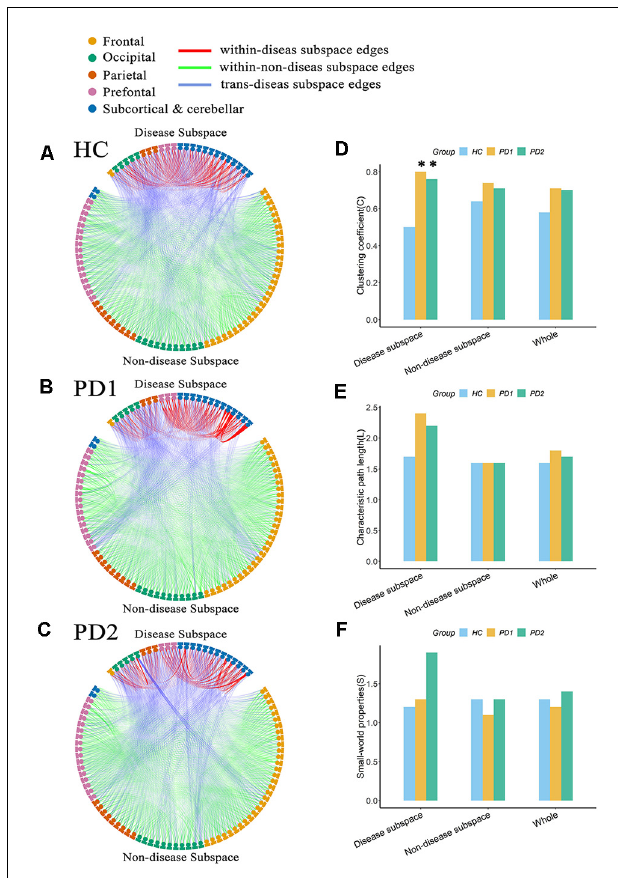
FIGURE 7 | Node-to-node functional connectivity (FC) in the (A) HC, (B) PD1, and (C) PD2 groups in the disease subspace and nondisease subspace, and (D–F) network attributes. (A) Binary functional network in the HC group at sparsity 38%. (B) Binary functional network in the PD1 group at sparsity 38%. (C) Binary functional network in the PD2 group at sparsity 38%. (D) Comparison of the clustering coefficient among HC, PD1, and PD2 groups in different spaces at sparsity 38%. (E) Characteristic path length. (F) Small world coefficient. In (A–C) , the nodes in the upper part of the circle represent brain regions in the disease subspace (25 ROIs), and the nodes in the lower part of circle represent brain regions in the nondisease subspace (70 ROIs). Colors of nodes on the circle represent different anatomical classifications of corresponding brain regions based on existing literature (Wang et al., 2007; Bai et al., 2011). The lines within the circle represent FC between pairs of nodes, where the red lines (within-disease subspace edges) indicate FC between nodes within the disease subspace; the green lines (within-nondisease subspace edges) indicate FC between nodes within the nondisease subspace; the blue lines (trans-disease subspace edges) indicate FC between the disease subspace nodes and the nondisease subspace nodes. The asterisk refers to significant differences between the PD compared to HC groups ( p <